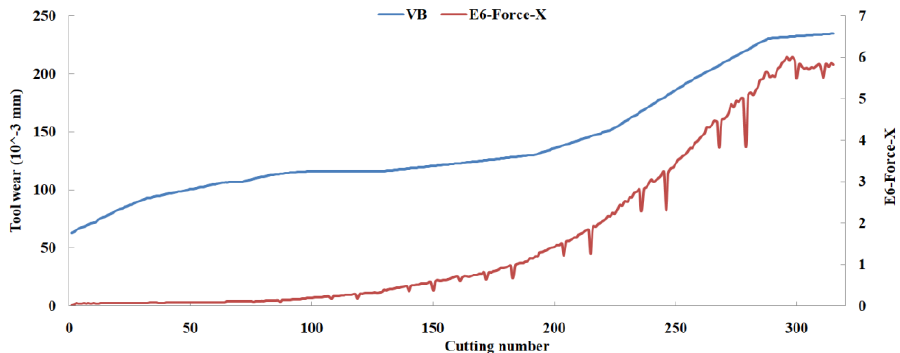
Figure 16. The scatter diagram between E 6 in X-dimension Force and tool wear value.